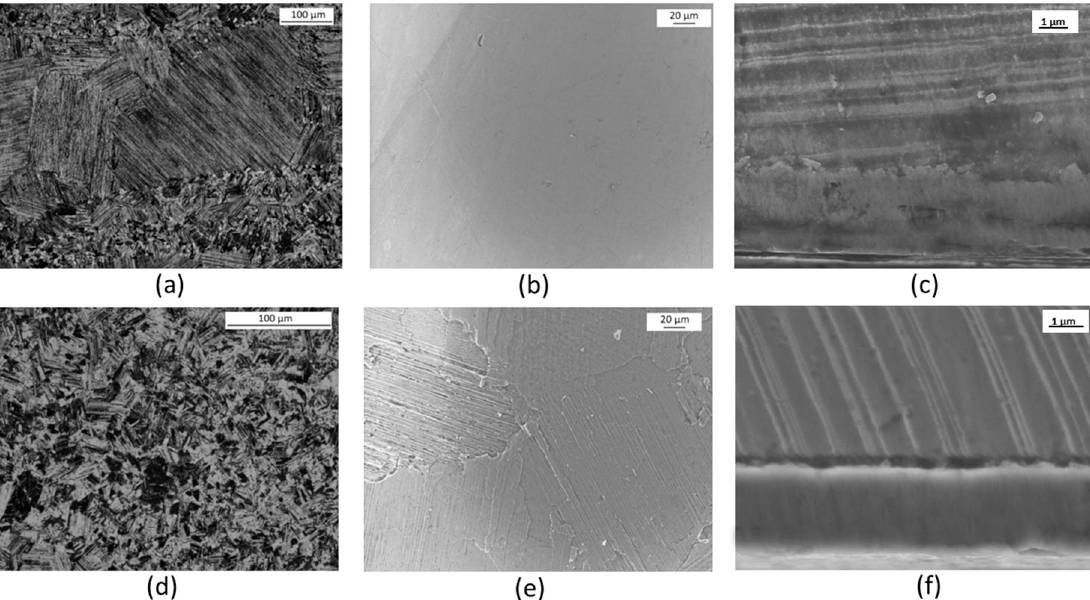
Figure 1. ( a ) Ti-Al intermetallic alloy, dual phase microstructure (optical microscope, etching by Kroll’s reagent); ( b ) coating surface of TiAlN1 specimen (SEM, InLens); ( c ) cross section of